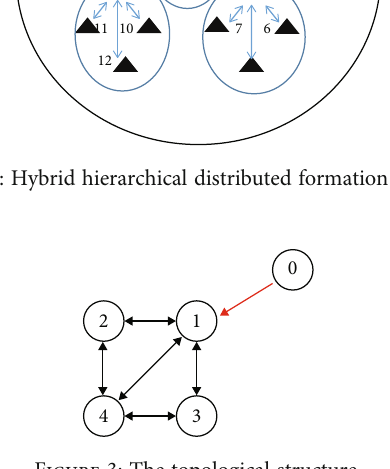
Figure 3: The topological